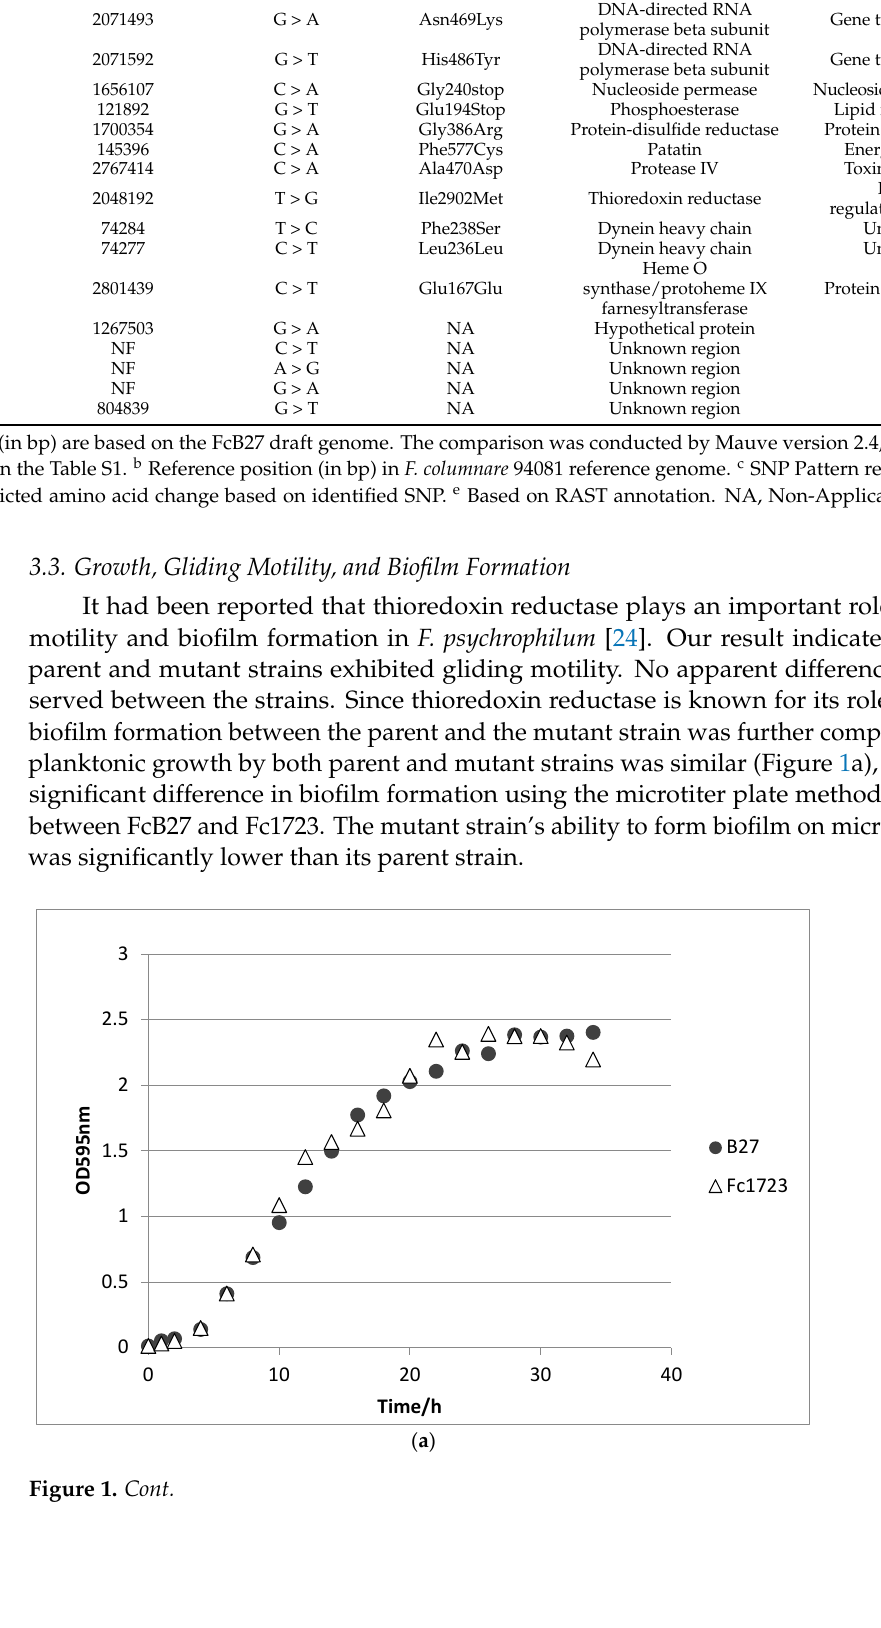
( b ) Figure 1. ( a ) Parent strain and vaccine strain growth curves. ( b ) Biofilm formation of virulent parent strain and vaccine strain after 48 h incubation in microtiter plate. * indicates significant difference. 4. Discussion Attenuated vaccines are regularly used in human and animal medicine to prevent disease. They tend to mimic the route of entry of pathogens, persist longer in the host (can even replicate in some cases) and induce a stronger immune response than bacterins [9,25]. Modified live vaccines elicit a wider range of immunologic responses, including both cell ‐ mediated and humoral, that are generally of greater magnitude and longer du ‐ ration than those produced by killed or subunit vaccines. In aquaculture, live attenuated vaccines can be easily administered as a timed bath treatment, which significantly reduces vaccine delivery costs when compared with injectable vaccines [26,27]. However, the use of live vaccines has safety concerns associated with the risk of reversion to a virulent form and the possibility of causing disease in immunocompromised individuals [28]. These concerns have hindered the application of live vaccines and, in some cases, have resulted in banning modified live vaccines from use [29,30].